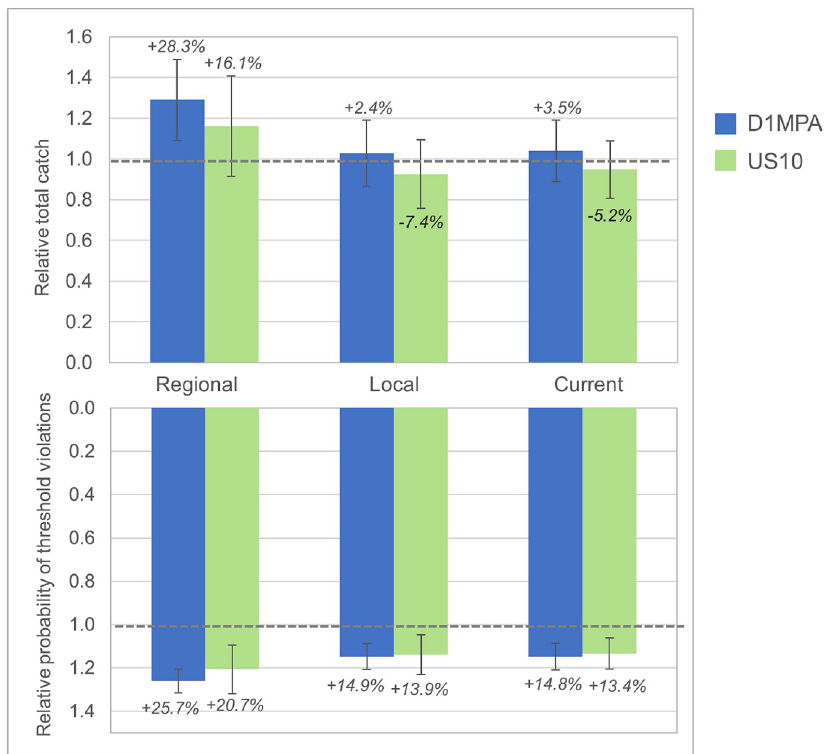
Fig 3. Relative total catches and probabilities of a threshold violation, at the scale of the model arena, across all redistribution alternatives in both MPA scenarios. Relative total krill catch in the final year of the model run (top bars) and the average probability of a threshold violation (bottom bars) by redistribution alternative for each MPA scenario (D1MPA in blue, US10 in green) relative to the No MPA reference. All other details as in Fig 2.